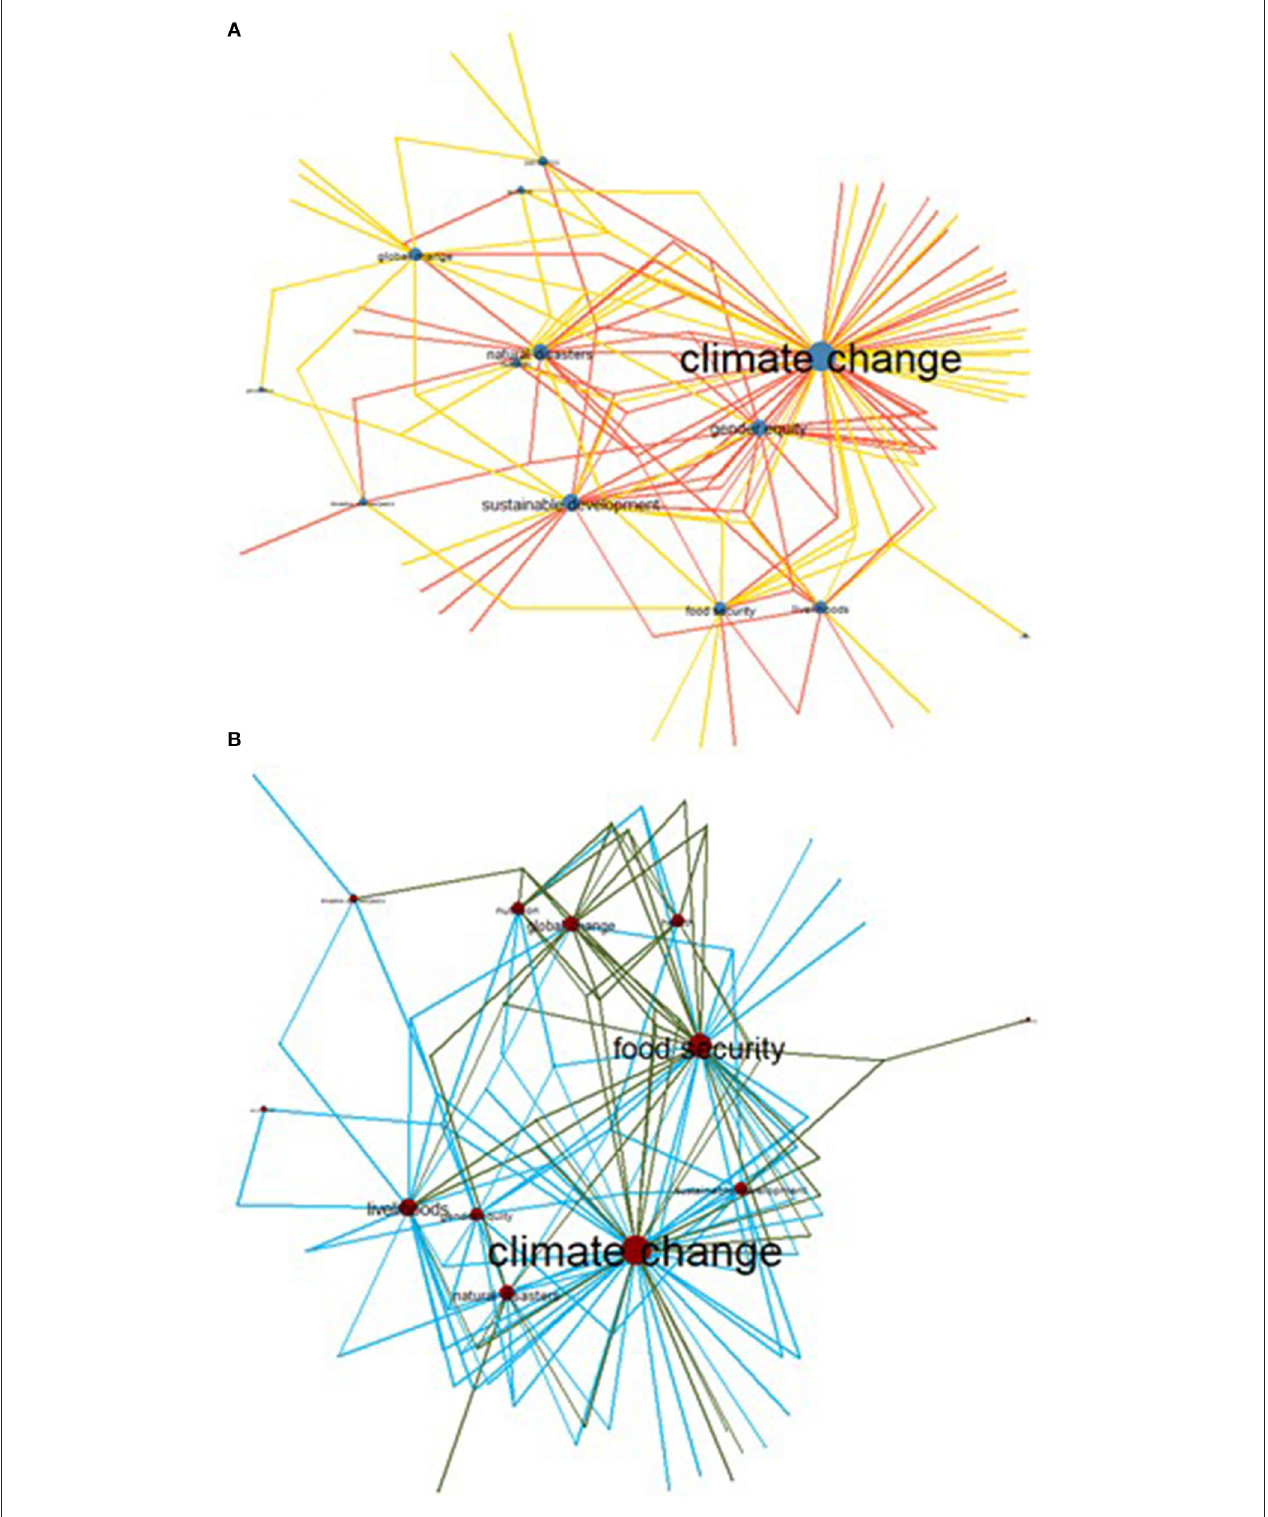
FIGURE 1 | Main topics in (A) Southeast Asian projects/initiatives (red) and research studies (yellow), and (B) PICTS projects/initiatives (blue) and research studies (green). Chart shows degree centrality scores based on networks disaggregated by region.